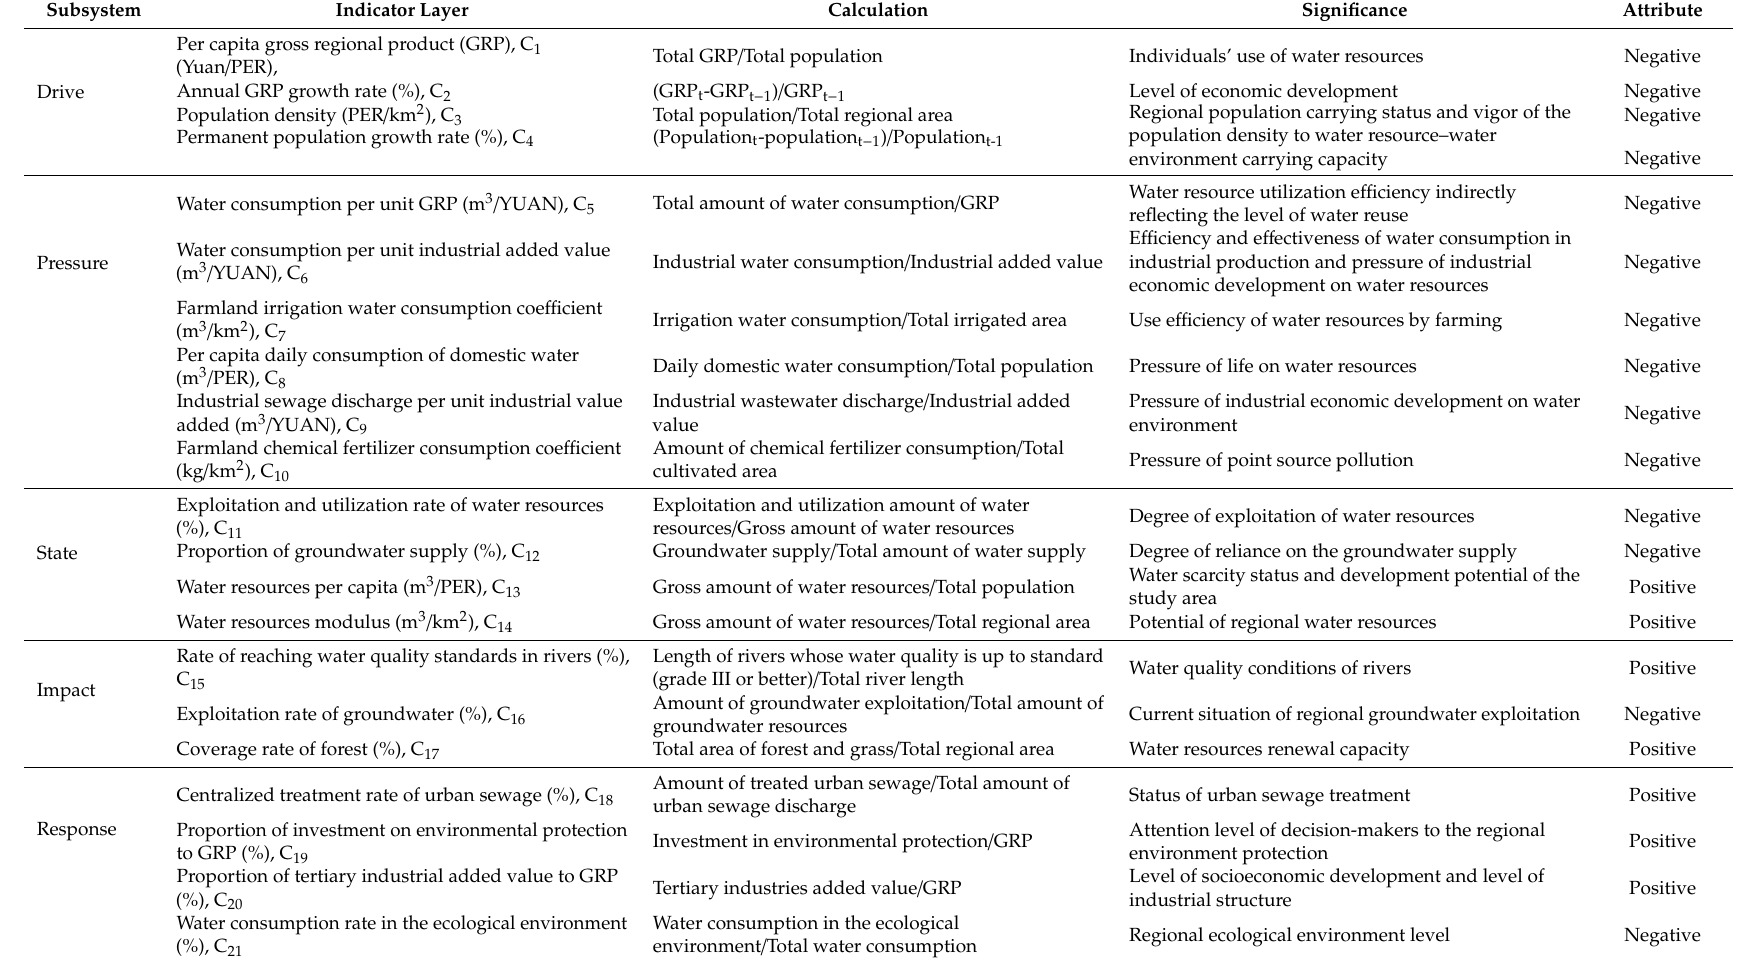
Table 2. Evaluation index system for the WRCC in